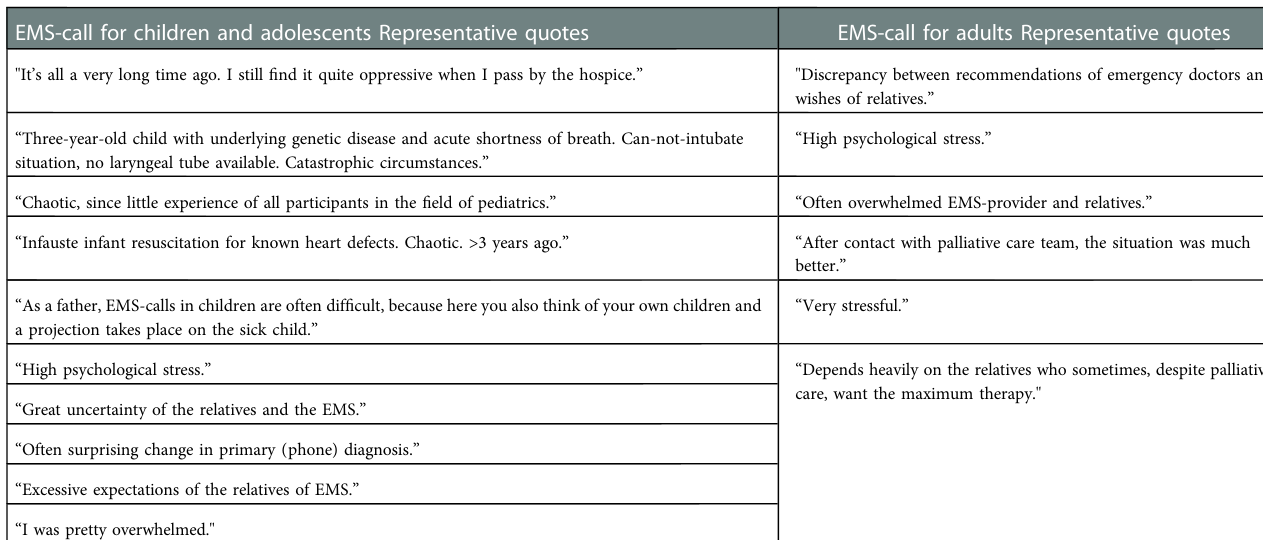
TABLE 2 Summary of memories of the participants regarding